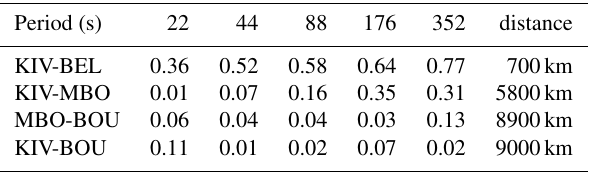
Table 1. Coherences between H components of observatories in “neighborhood” (KIV-BEL) and “inter-continental” (all others) distances. See Sect. 2 for their locations. Data from the entire March 2013.